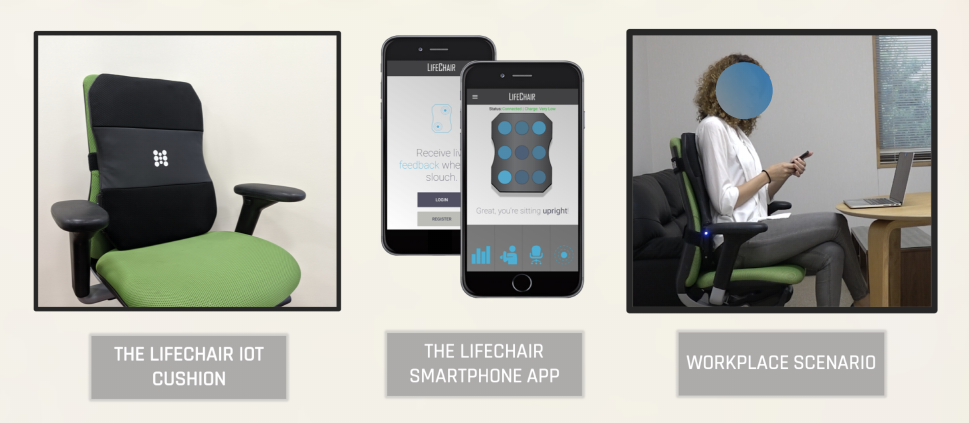
Figure 1. The LifeChair posture training system: The LifeChair IoT cushion ( left ) and the LifeChair smartphone app ( center ) in a workplace scenario ( right